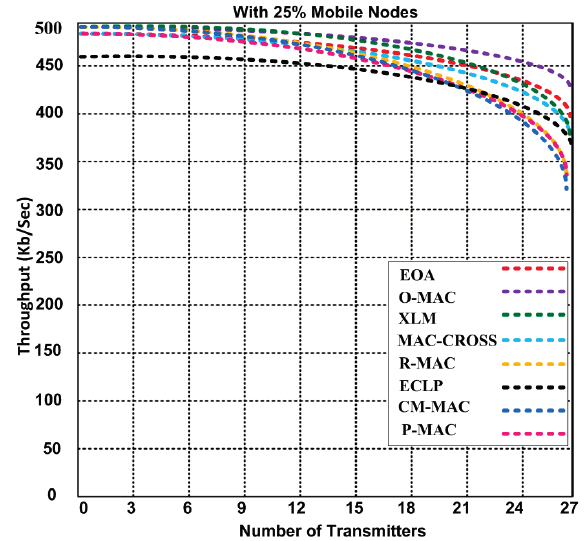
Figure 12. Throughput of O-MAC and other competing hybrid MAC protocols with a varying number of